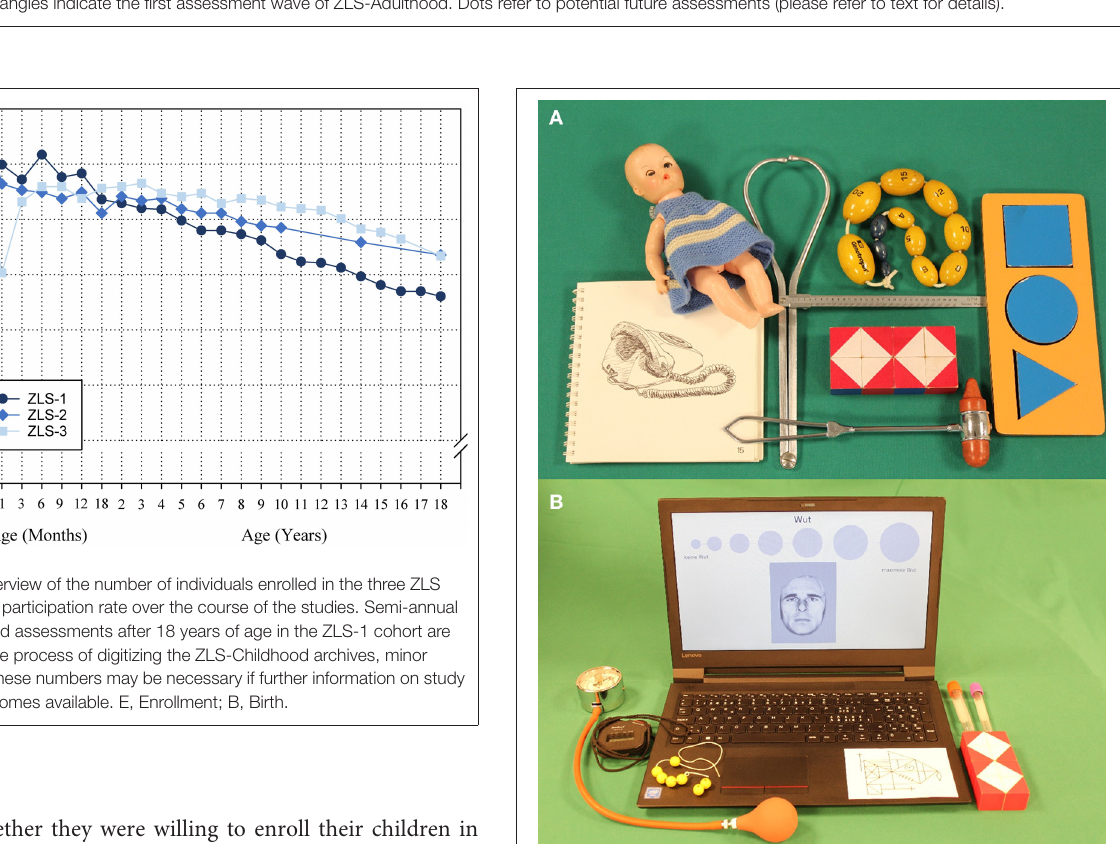
participants, and in 2007/2008, a subset of ZLS-2 ( n = 77) and ZLS-3 participants ( n = 50) took part in an independent study on motor abilities (both